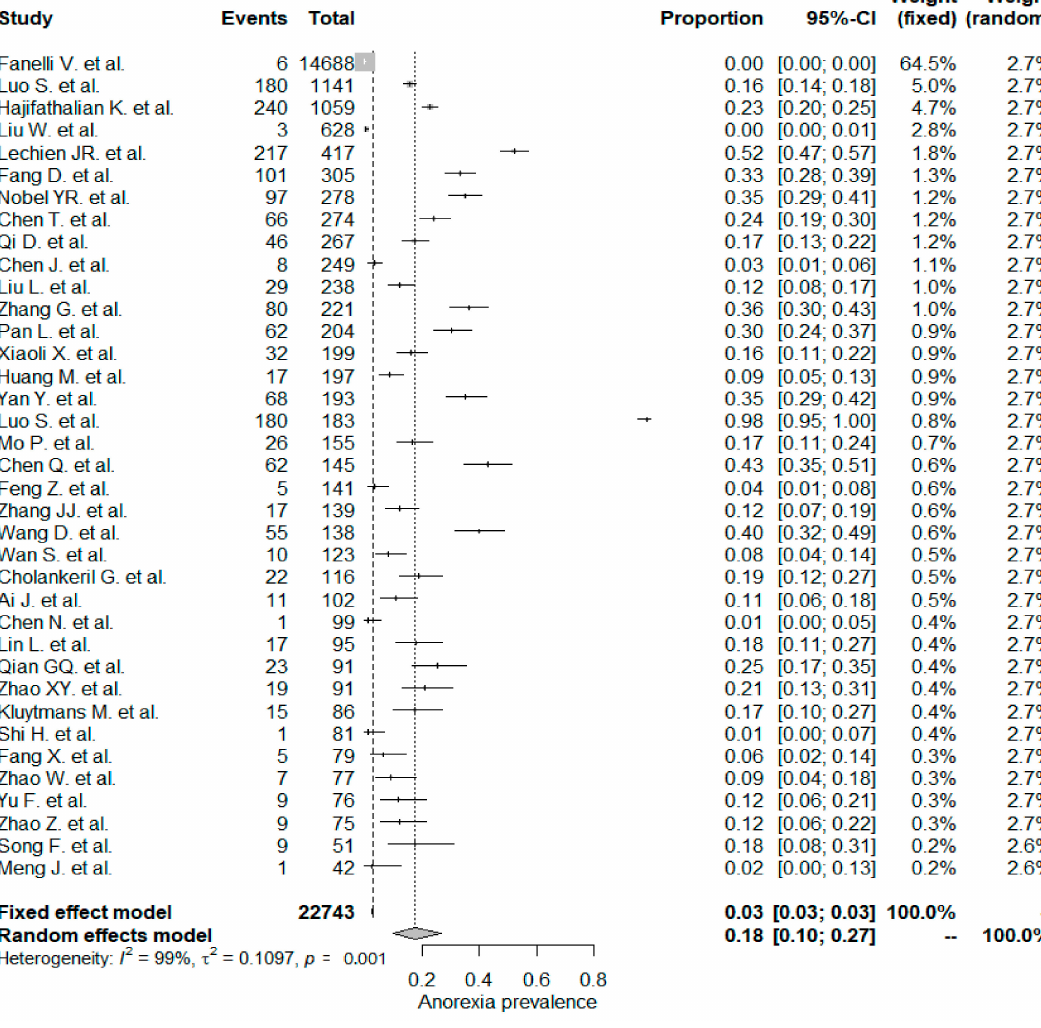
Figure 5. All studies, anorexia forest plot and meta-analysis